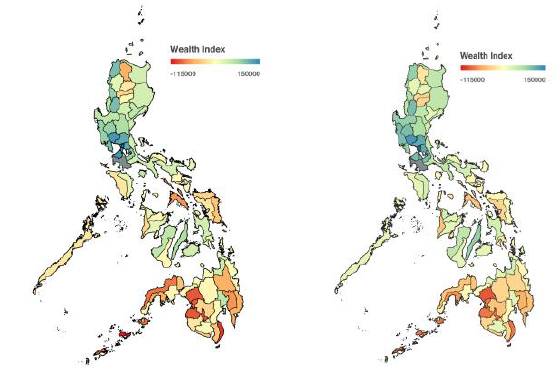
Figure 3. Ground-truth wealth indices and cross-validated Philippine poverty predictions using the satellite-based transfer learning model aggregated to the provincial level.